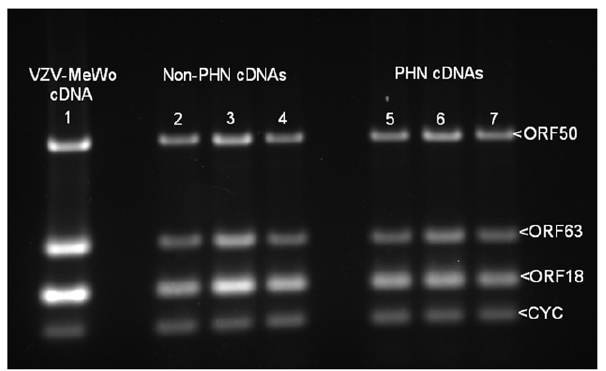
Figure 2. VZV gene 63, 18, and 50 transcripts in infected ND7/ 23 1.8 cells. End point PCR analysis depicting expression of the VZV genes ORF63 IE , ORF18 E and ORF50 L relative to the housekeeping gene cyclophilin (CYC) in; VZV infected MeWo cells (Lane1), ND7/23-Nav1.8 cells infected with SVSs prepared from three non-PHN (Lanes 2–4) and three PHN (Lanes 5–7) MeWo cell lines.